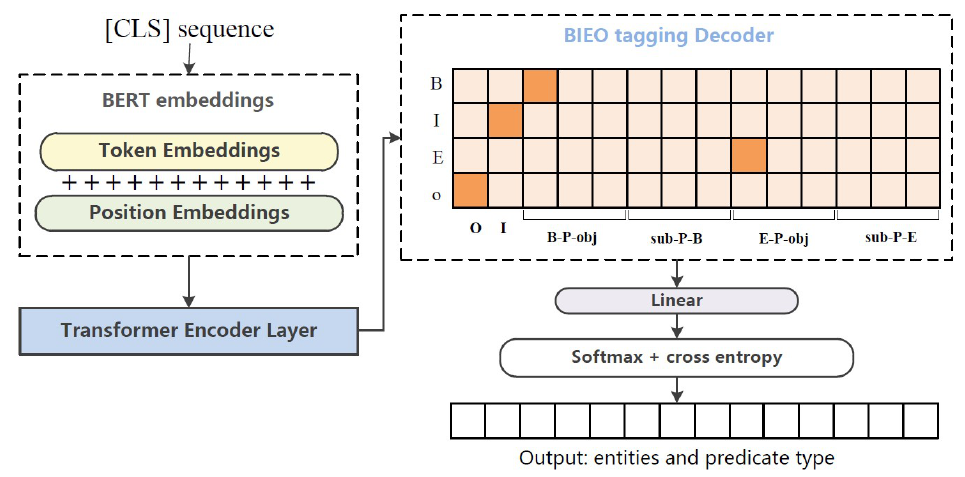
Figure 2. An illustration of proposed regulations information extraction (IE) module.